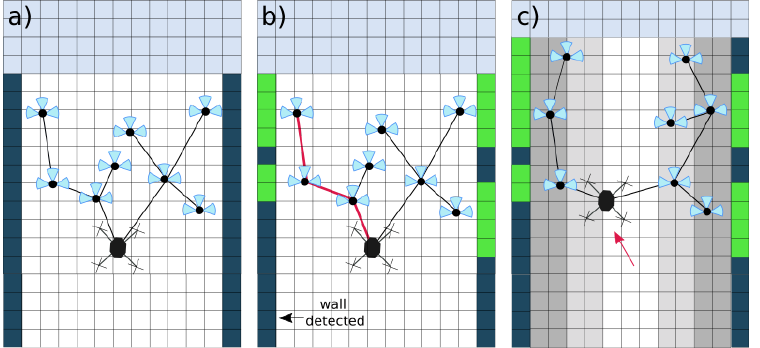
Figure 4. Instances of the tree expansion and execution using the guided sampling approach: ( a ) The tree is expanded from the current robot position in a uniform manner. ( b ) The samples have been evaluated, and the most informative trajectory is selected (marked in red). While the platform is moving within the environment, the tunnel walls are detected. ( c ) In an RH fashion, the robot moves to the first node of the best branch and samples again the search space. This time, a discrete probability distribution is applied. The weights of each discrete interval are computed based on the information gain of each sample falling in that